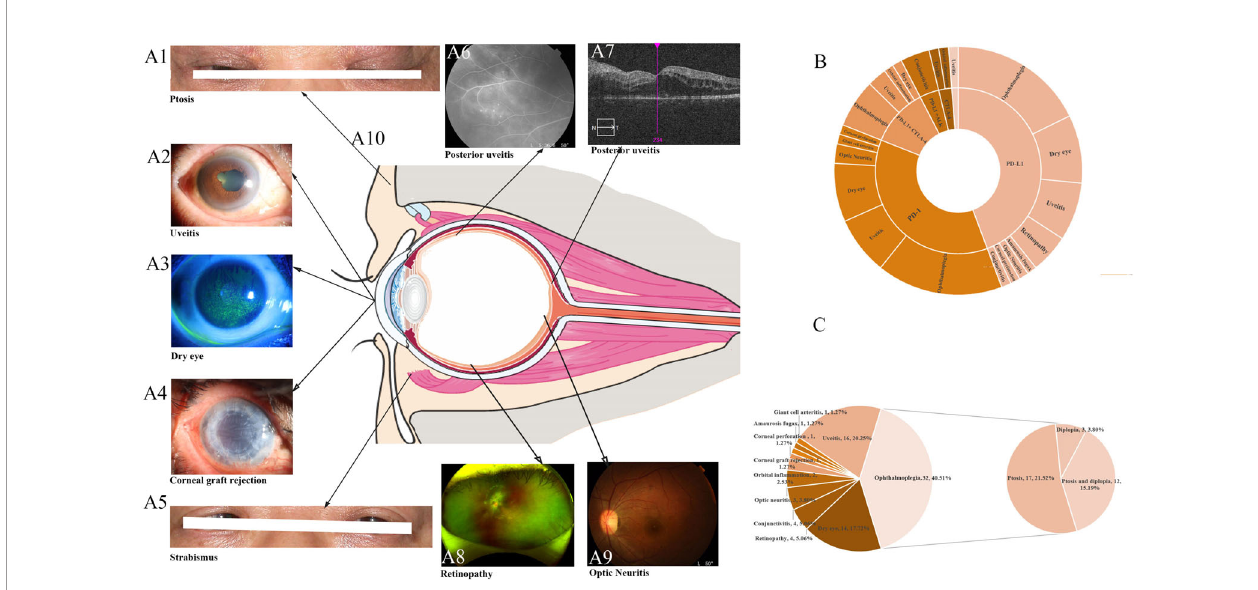
FIGURE 1 | Clinical characteristics (A) and the distribution (B, C) of immune checkpoint inhibitor-mediated ocular side events. (A) The clinical characteristics of common ocular irAEs in lung cancer. (B) The distribution of ocular irAEs in different therapies. (C) A summary of all reported ocular irAEs in lung cancer following treatment with